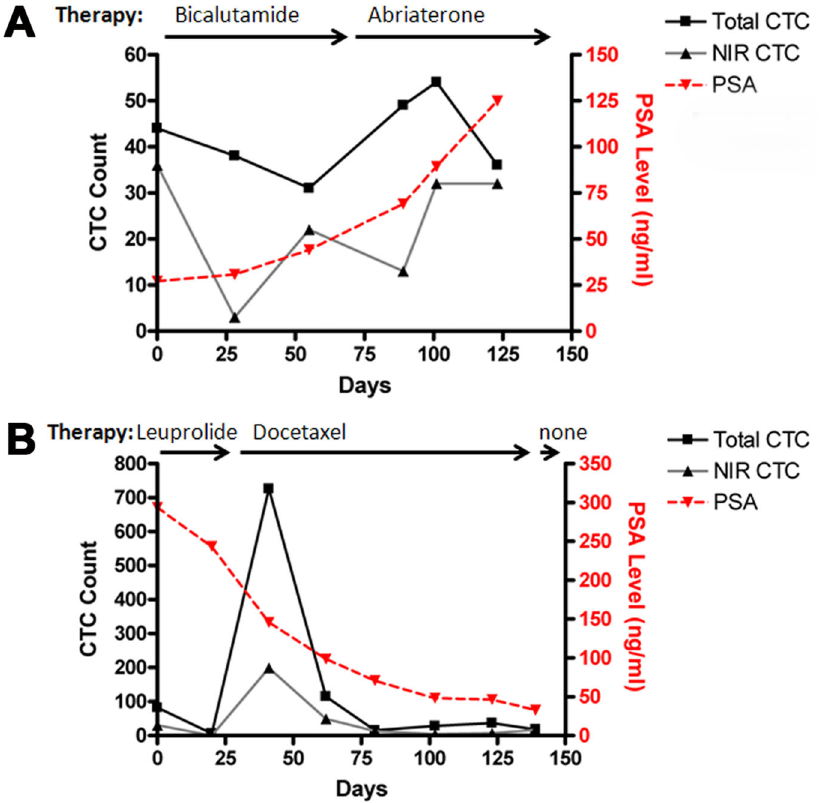
Figure 3. Live CTC counts as an independent indicator of disease progression. CTC counts detected from mCRPC patients were analyzed along with the progress of therapeutic intervention. Two representative results are shown. A , the progressive increment of CTC counts in patient 41 correlated with clinical metastatic progression. B , the persistent low CTC counts in patient 42 correlated with beneficial anticancer therapies.